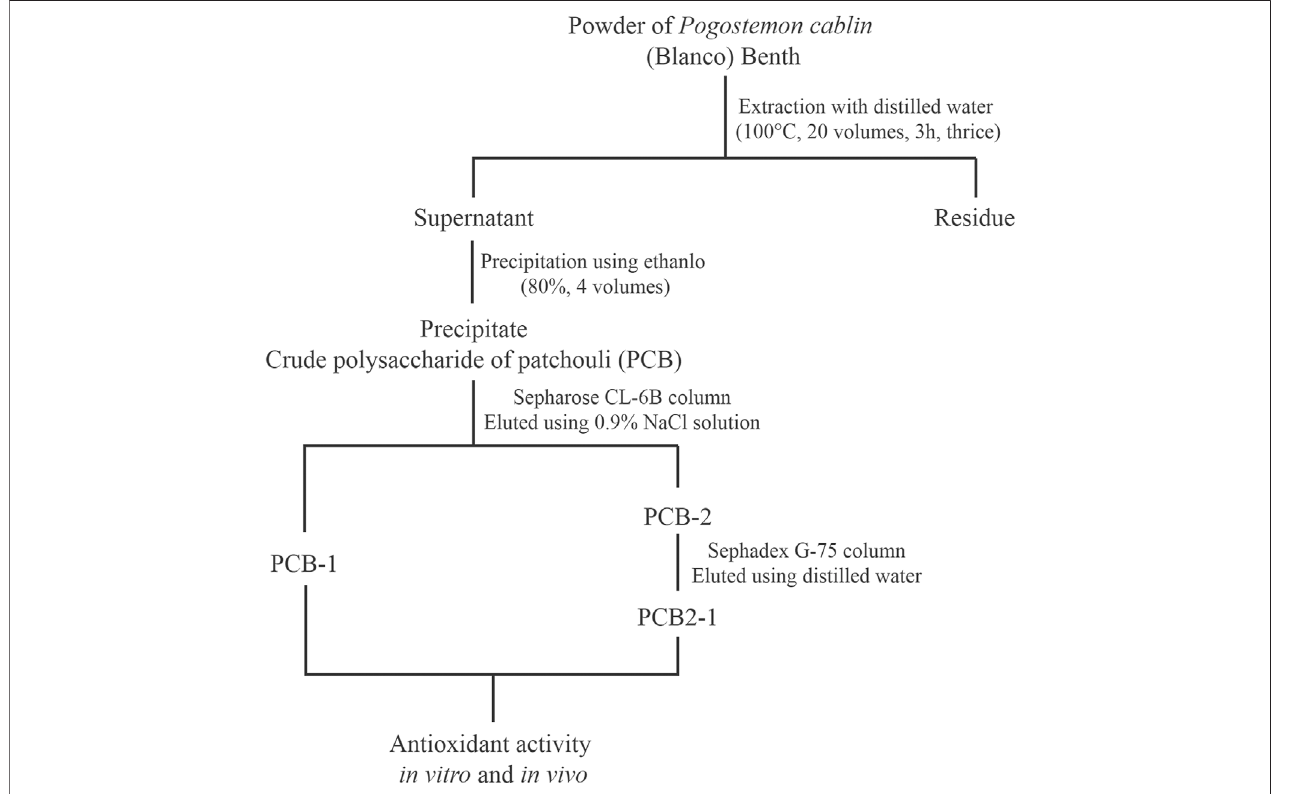
FIGURE 1 | Experimental procedure for extraction and puri fi cation of polysaccharides isolated from P. cablin .